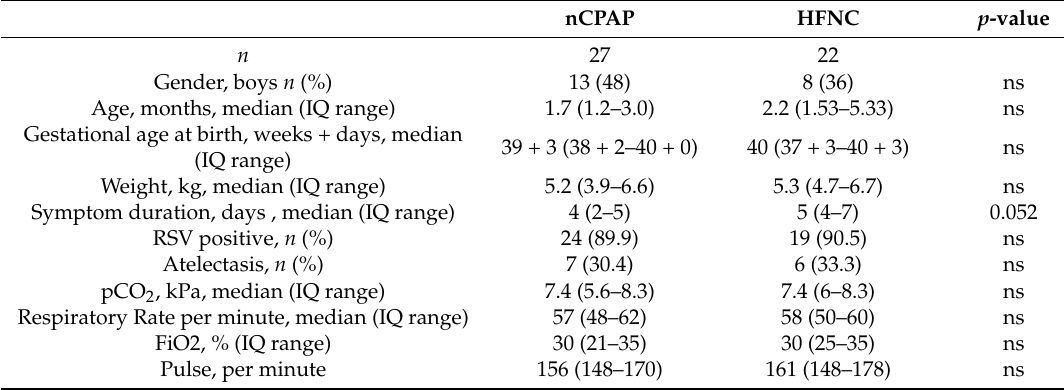
Table 2. Duration of treatment, hospital stay and system failure.